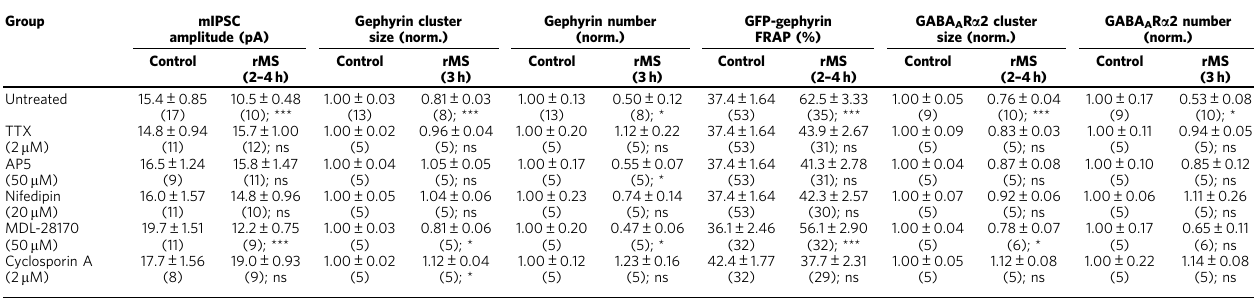
Table 1 | rMS recruits calcium-dependent signalling pathways to induce plasticity of inhibitory postsynapses. Group mIPSC Gephyrin cluster Gephyrin number amplitude (pA) size (norm.)